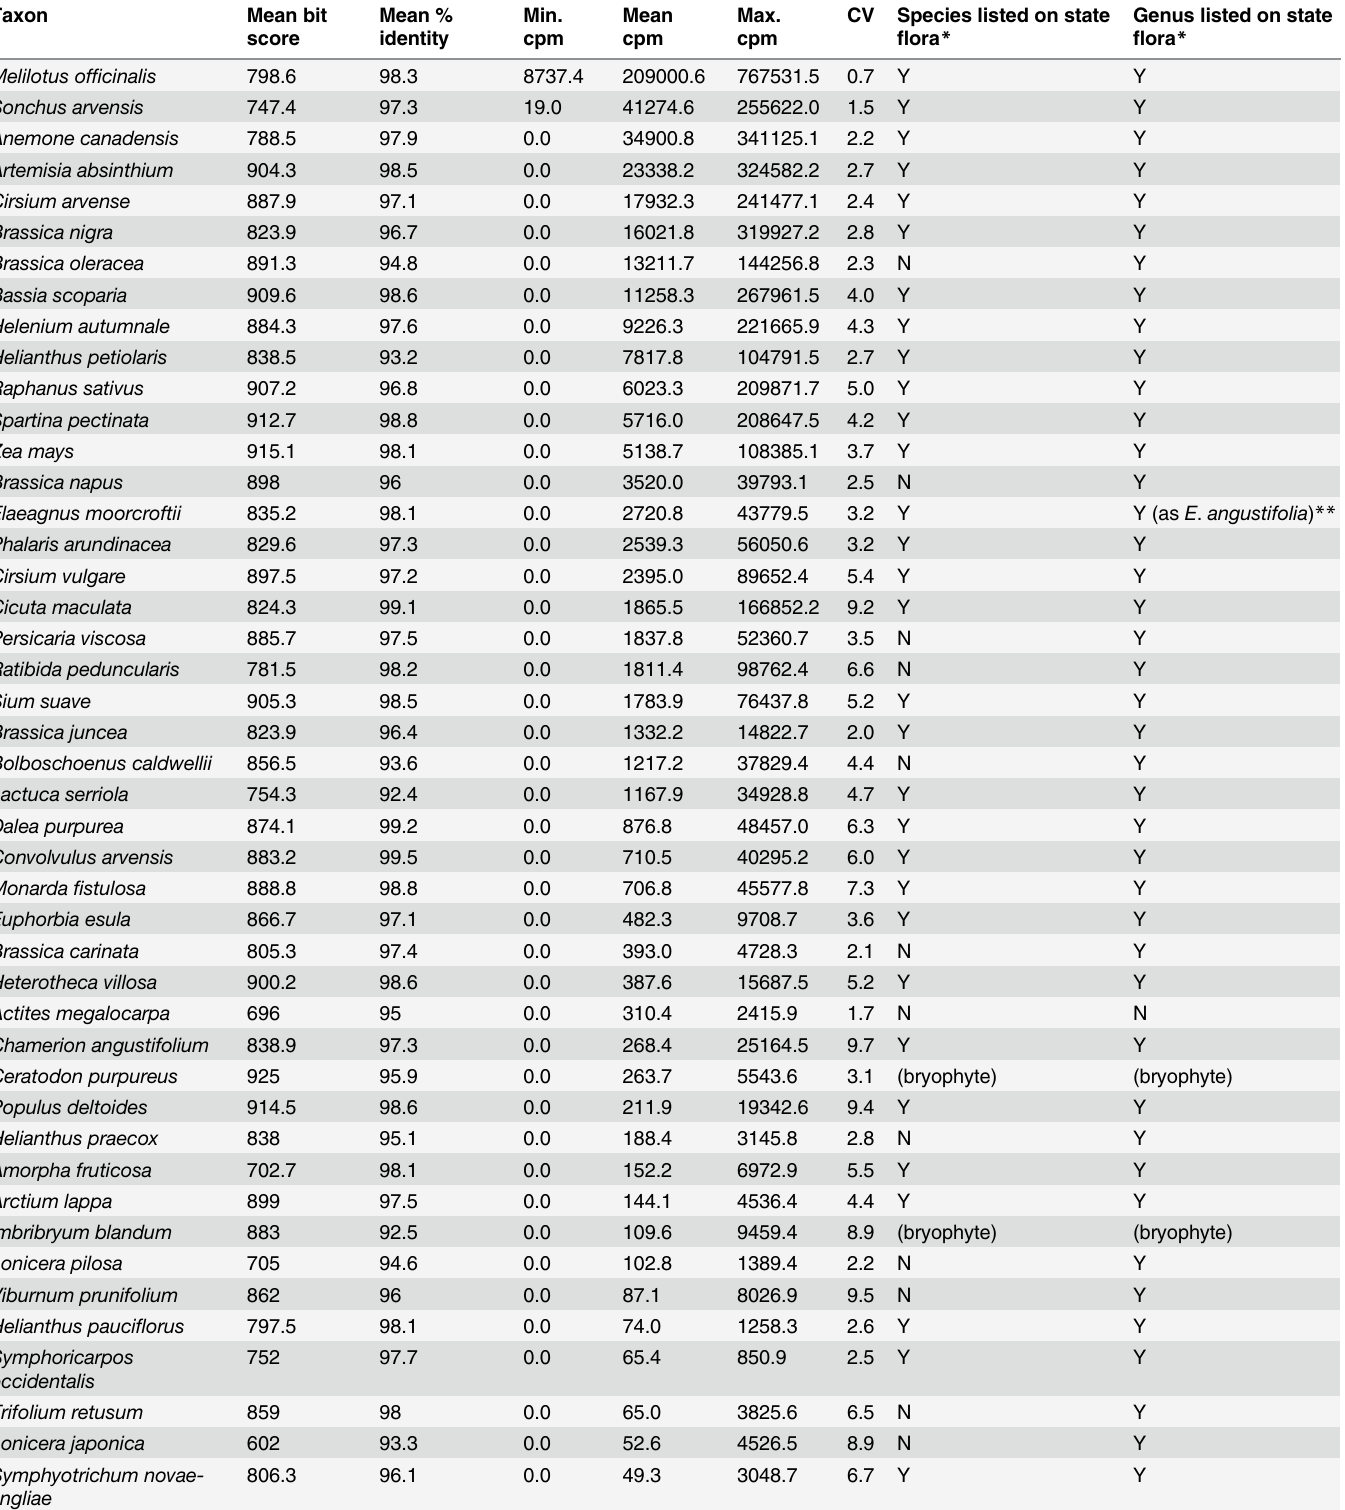
Table 1. Taxonomic assignments to species within Viridiplantae (green plants), sorted by the mean read counts per million (cpm).